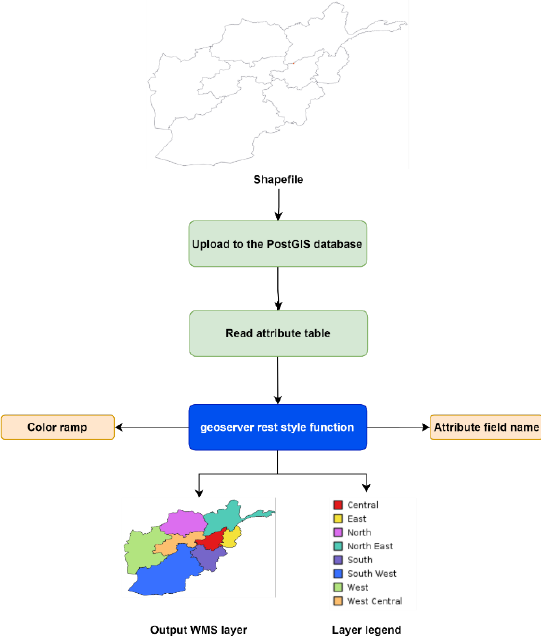
Figure 7. Process of generation of WMS layer of raster dataset using geoserver-rest. The input data is the administrative regions of